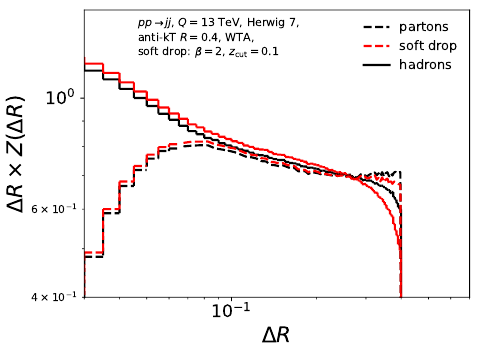
Figure 15 . Jet shape at the LHC for jets with p T;J > 200 GeV at hadron (solid) and parton level (dashed), using all particles (black) or after applying soft drop (red).